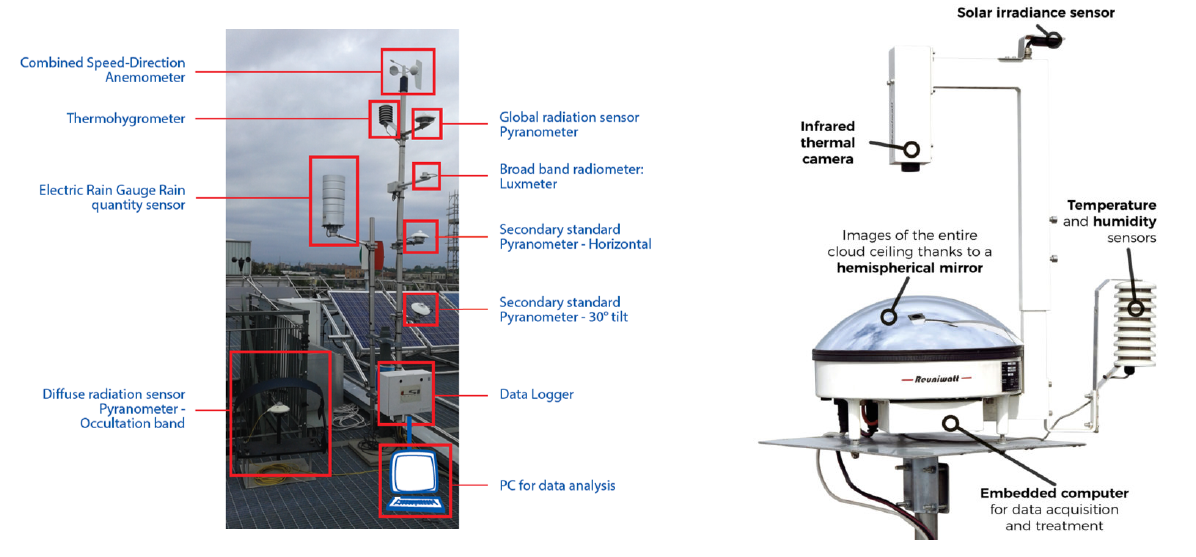
Figure 2. Weather station sensors ( left ) and 3D scheme of a whole-sky camera ( right ). Figure 3 shows an example of infrared image acquired with the described system: the blue part corresponds to the clear sky, the clouds are represented by different shades of color and the sun is indicated by a black dot. The central red area and the surroundings are part of the whole-sky camera structure [31].